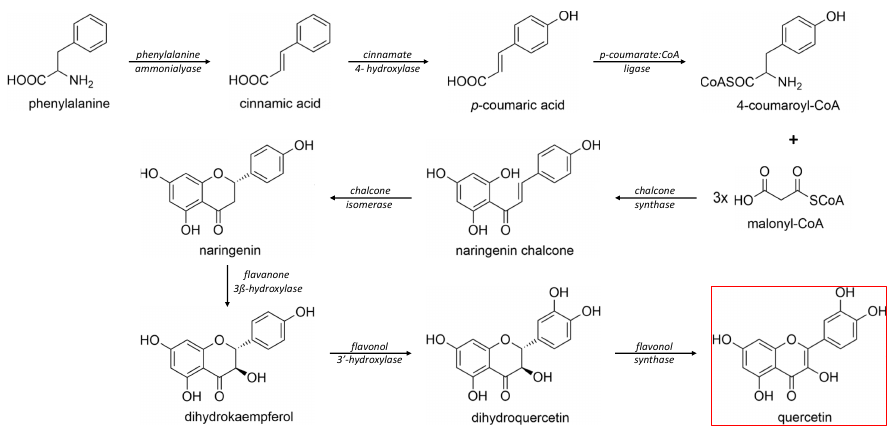
Figure 2. Schematic biosynthesis mechanism of quercetin from phenylalanine. Catalytic enzymes responsible are denoted in italics over the arrows. Quercetin, the final product, is marked with a red rectangular border. Table 2. Selected quercetin derivatives alongside the position of the modification (see Figure 1 for correspondent numbers of the carbon atoms).